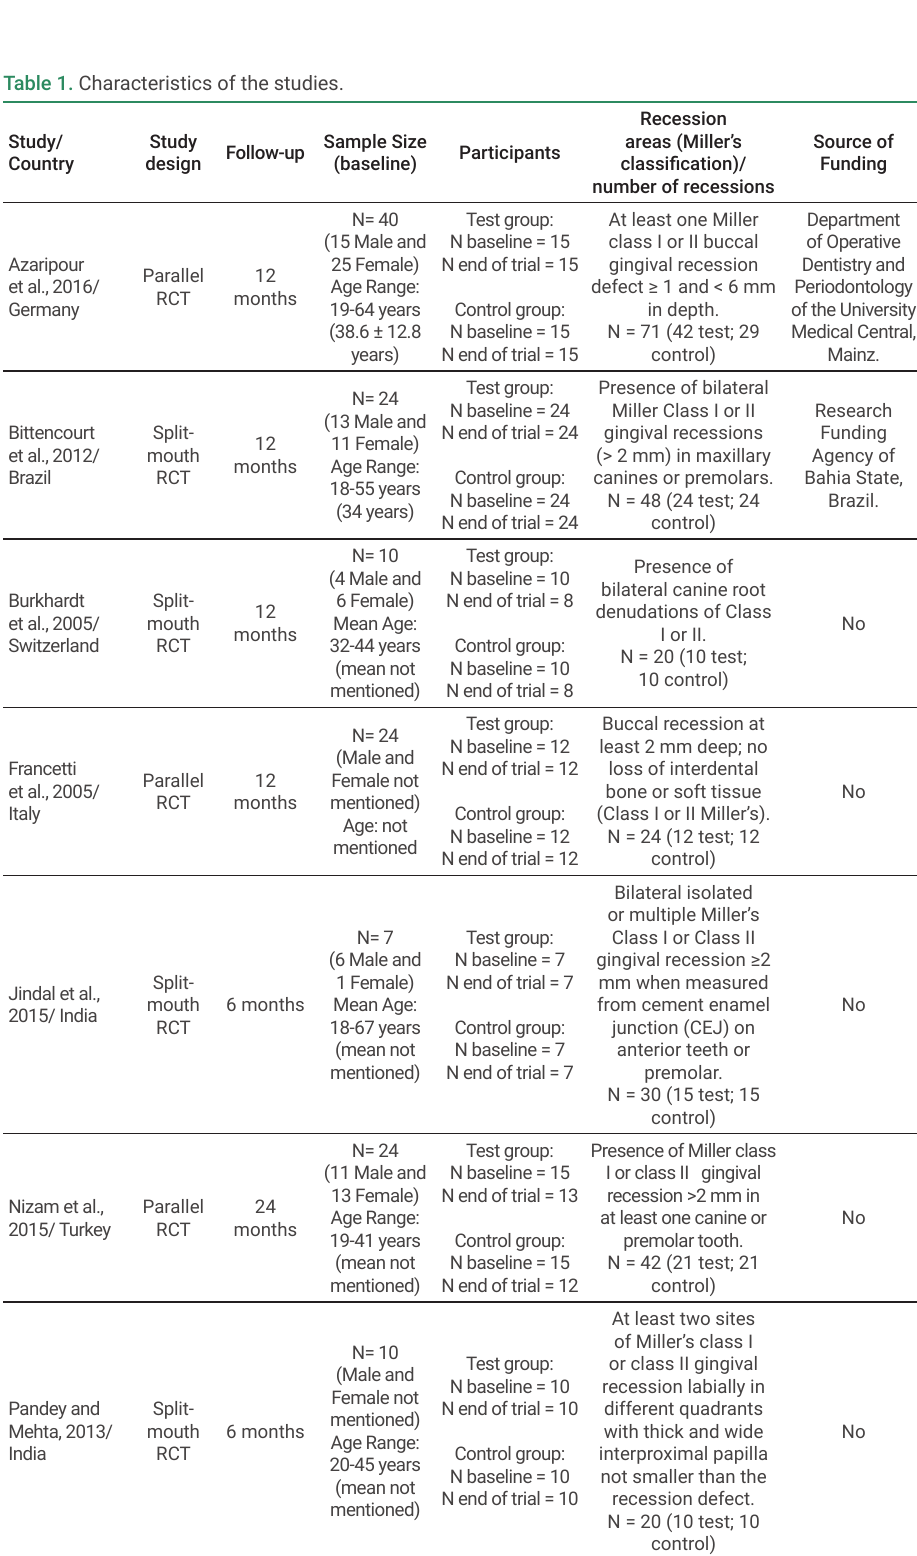
Table 1. Characteristics of the